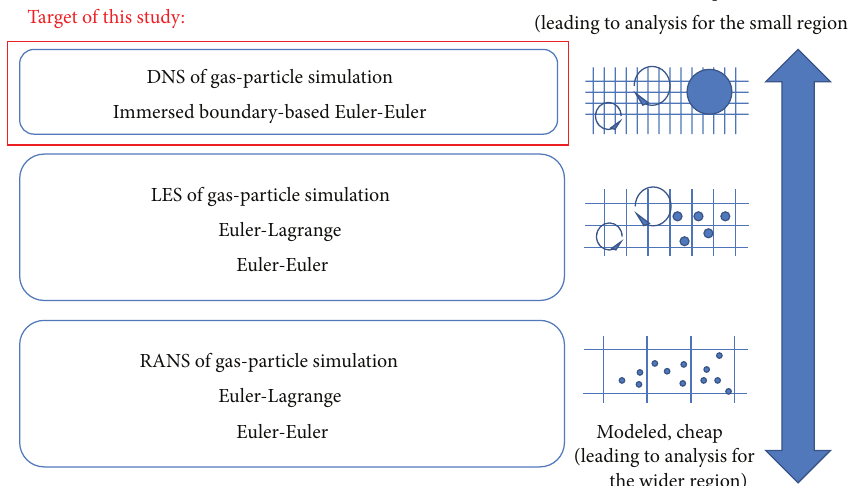
Figure 1: Overview of the proposed gas-particle